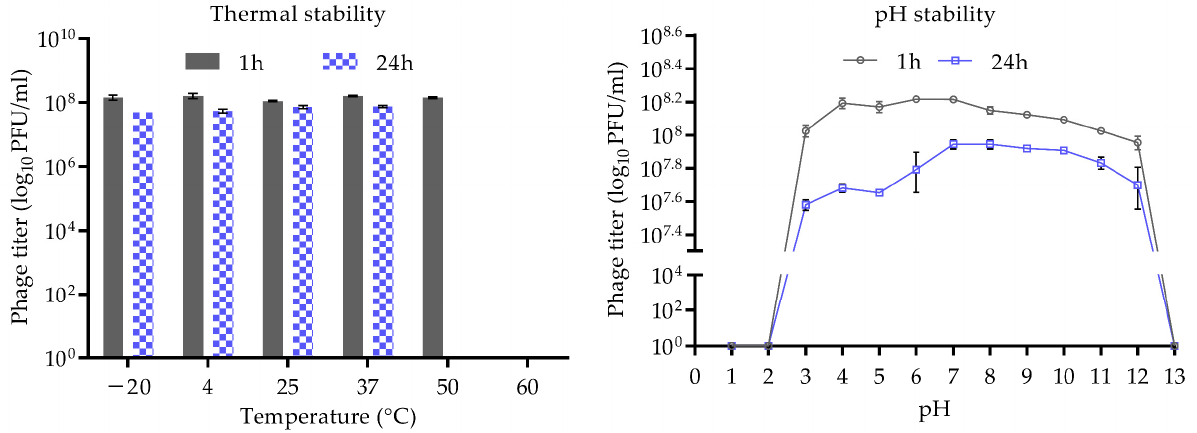
Figure 4. Thermal and pH stability test of CUB-EPI_14. Temperature experiments were performed for 1 h and 24 h at pH 7. pH experiments were performed for 1 h and 24 h at room temperature (25 °C). Error bars represent SD.